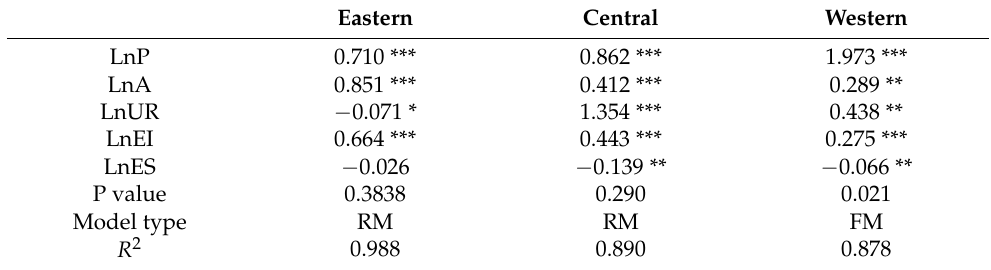
Table 4. Drivers of differences in RCE between the different regions of China during 2010–2019. Eastern Central Western LnP 0.710 ***